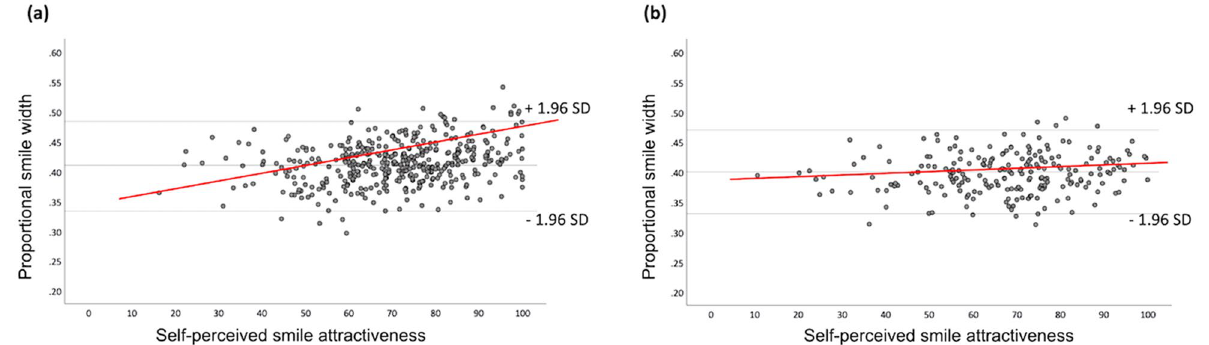
Figure 3. Linear regression of proportional smile width on self-perceived smile attractiveness, in ( a ) females and ( b ) males. (Images were created using SPSS version 26.0, https ://www.ibm.com/produ cts/spss-stati stics